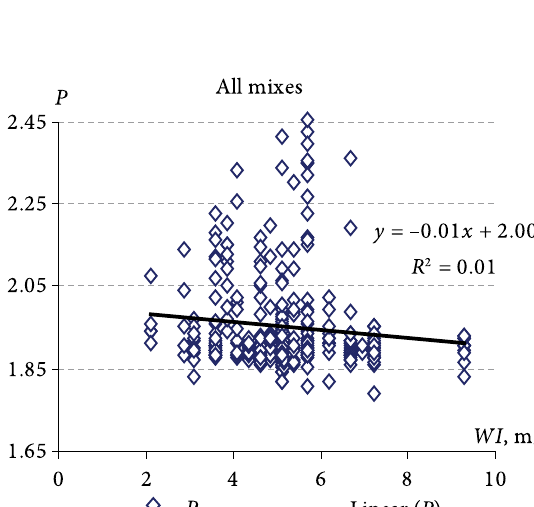
Fig. 6. P CE vs. T